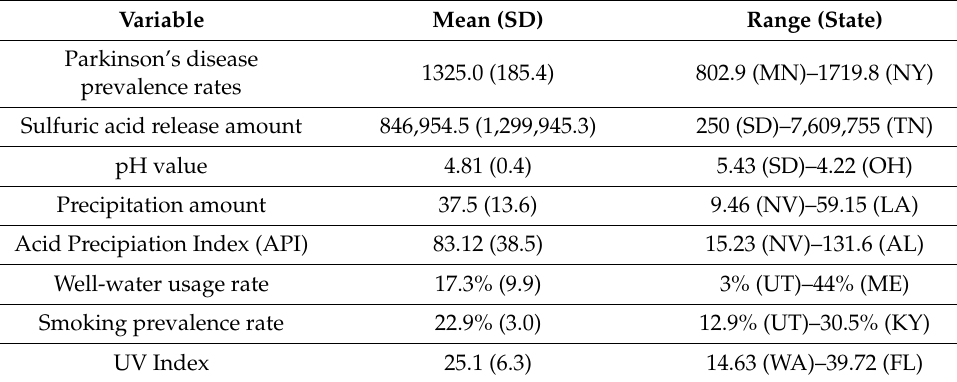
Table 1. Summary statistics for predictor